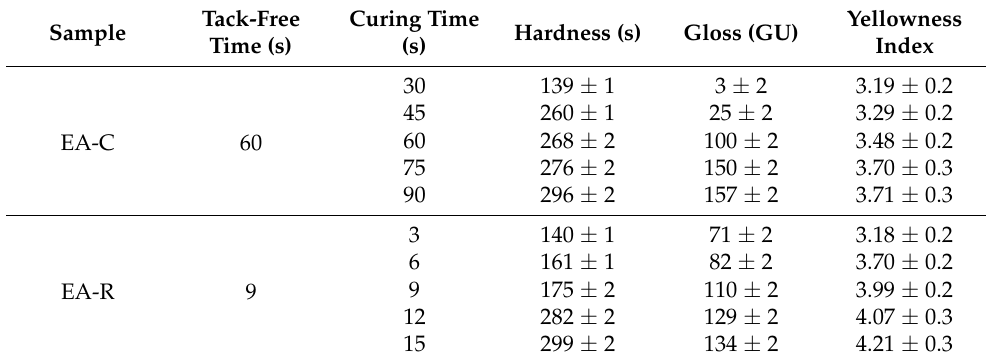
Table 2. The basic properties of the cured coatings depend on the photopolymerization (C–cationic, R–radical) and the duration of UV radiation exposure time (mercury UV lamp, 280–400 nm, 200 mW/cm 2 ; composition of the photoreactive formulations: 96 wt% of EA prepolymer, 4 wt% of cationic